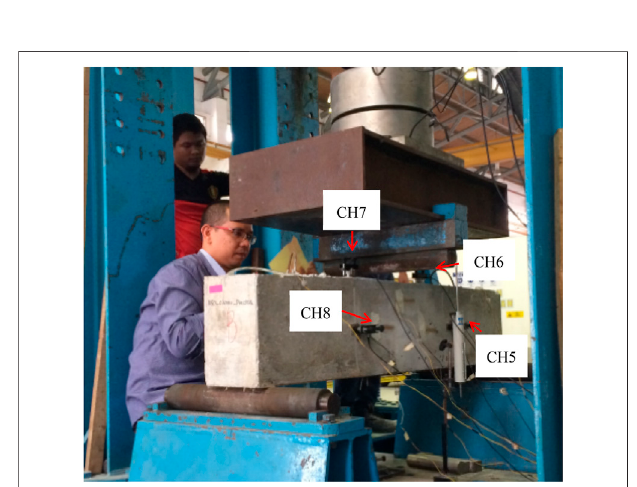
FIGURE 6 | Beam set up and set up of all